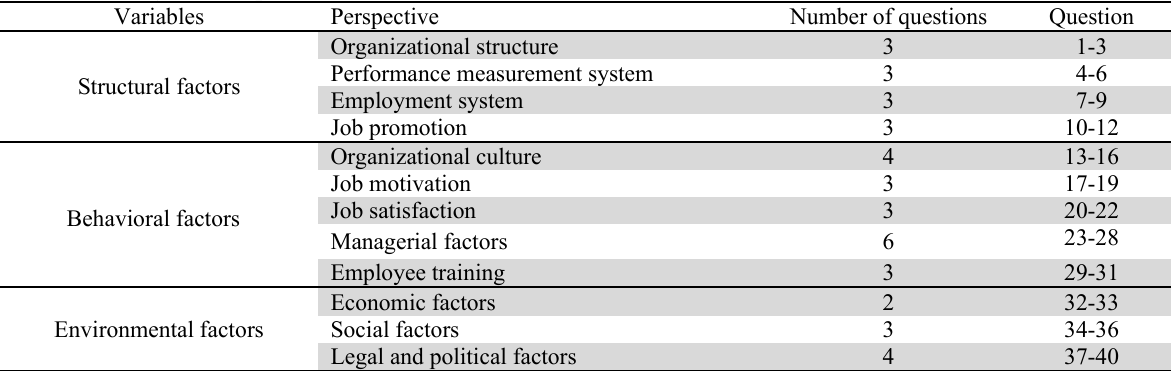
The summary of the